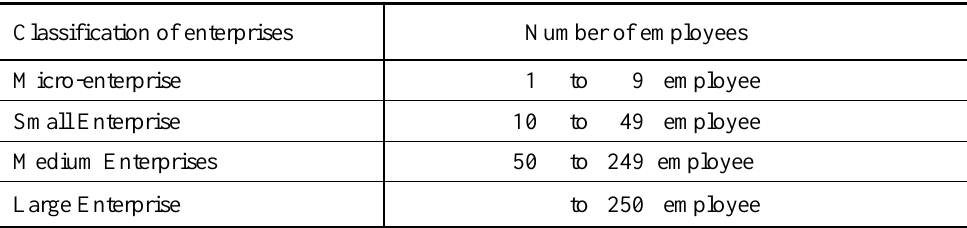
Table 7 . Classification of enterprises in